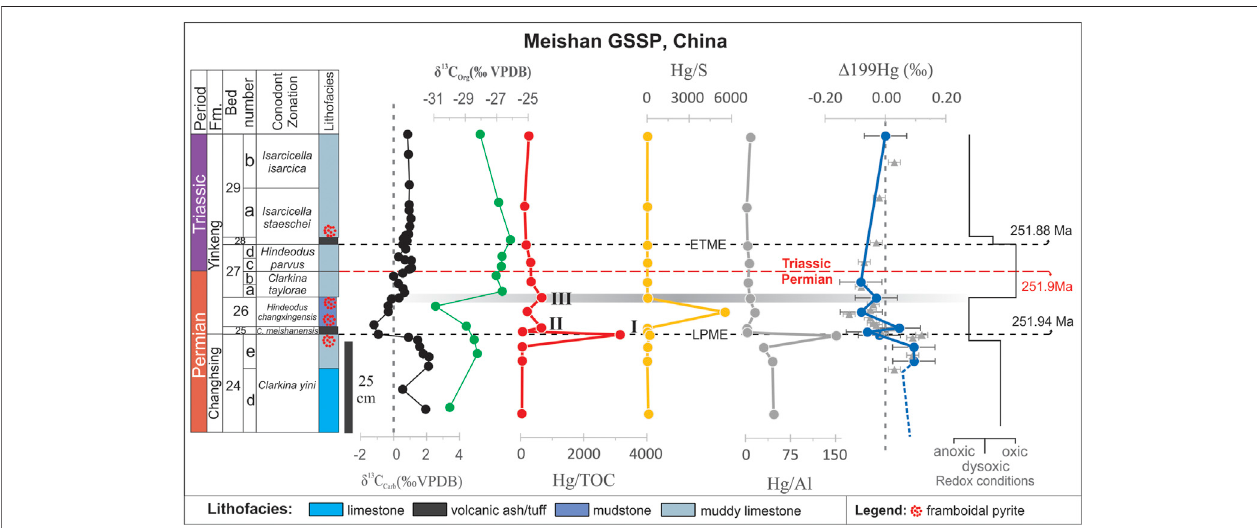
FIGURE 4 | Lithostratigraphy and conodont biozones for the Meishan D (GSSP) section, according to Chen et al. (2015); δ 13 C carb curve is from Chen et al. (2005) andthisstudy; δ 13 C org andHg/TOCchemostratigraphicpathwaysweremodi fi edfromSialetal.(2020a);Hg/S( (cid:1) Hg/Totalsulfur,TS),Hg/Aland Δ 199 Hg ‰ (MIF)variation patterns are from this study. Gray stars along the Δ 199 Hg ‰ (MIF) variation curve represent samples from Grasby et al. (2017). Variations in redox conditions are according to Shen et al. (2007), based on the size distribution of framboidal pyrite.